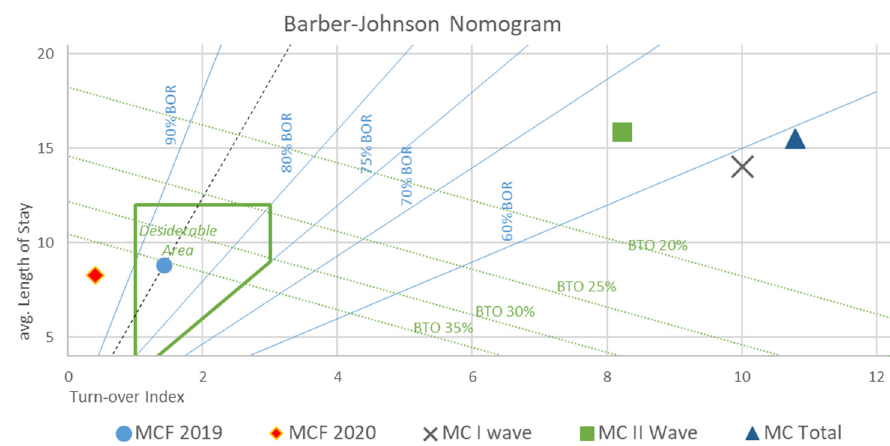
Figure 4. Barber–Johnson nomogram depicting ward performances during 2019–2020 period. x -axis: average length of stay (days); y -axis: turnover index (days).